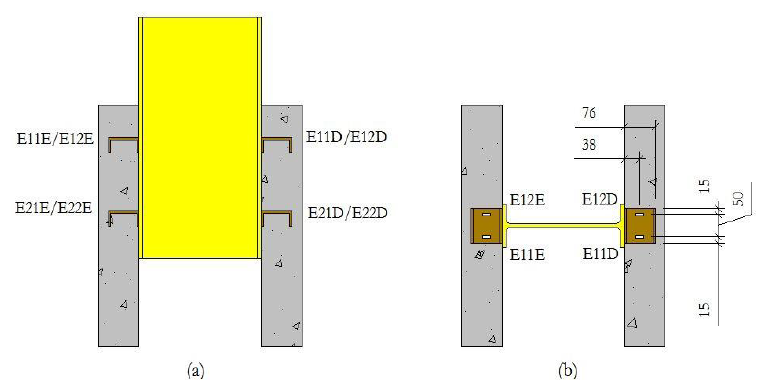
Figure 7. Positioning of shear connectors: (a) front view; (b) top